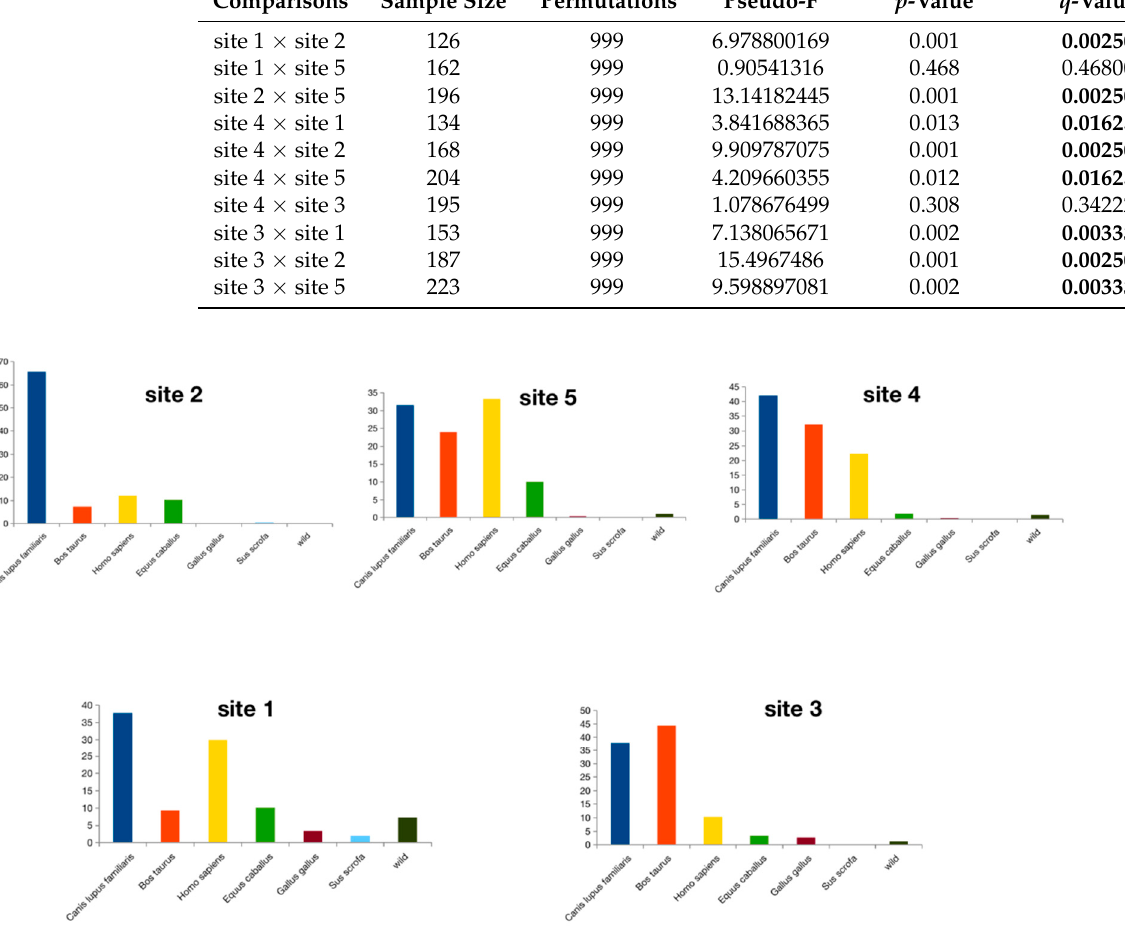
Figure 4. Bar charts representing the proportion of ingested blood from different hosts for Mansonia in different collection points. Values in bold denote statiscrical significance at the q < 0.05 level.